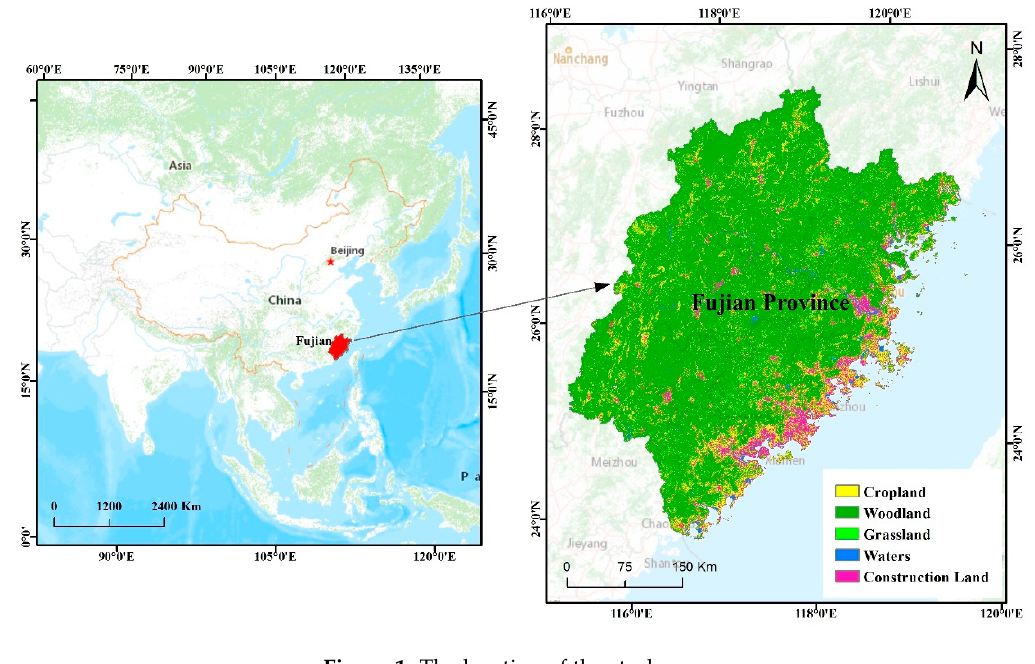
Figure 1. The location of the study area. Table 1. Basic economic information of Fujian Province.